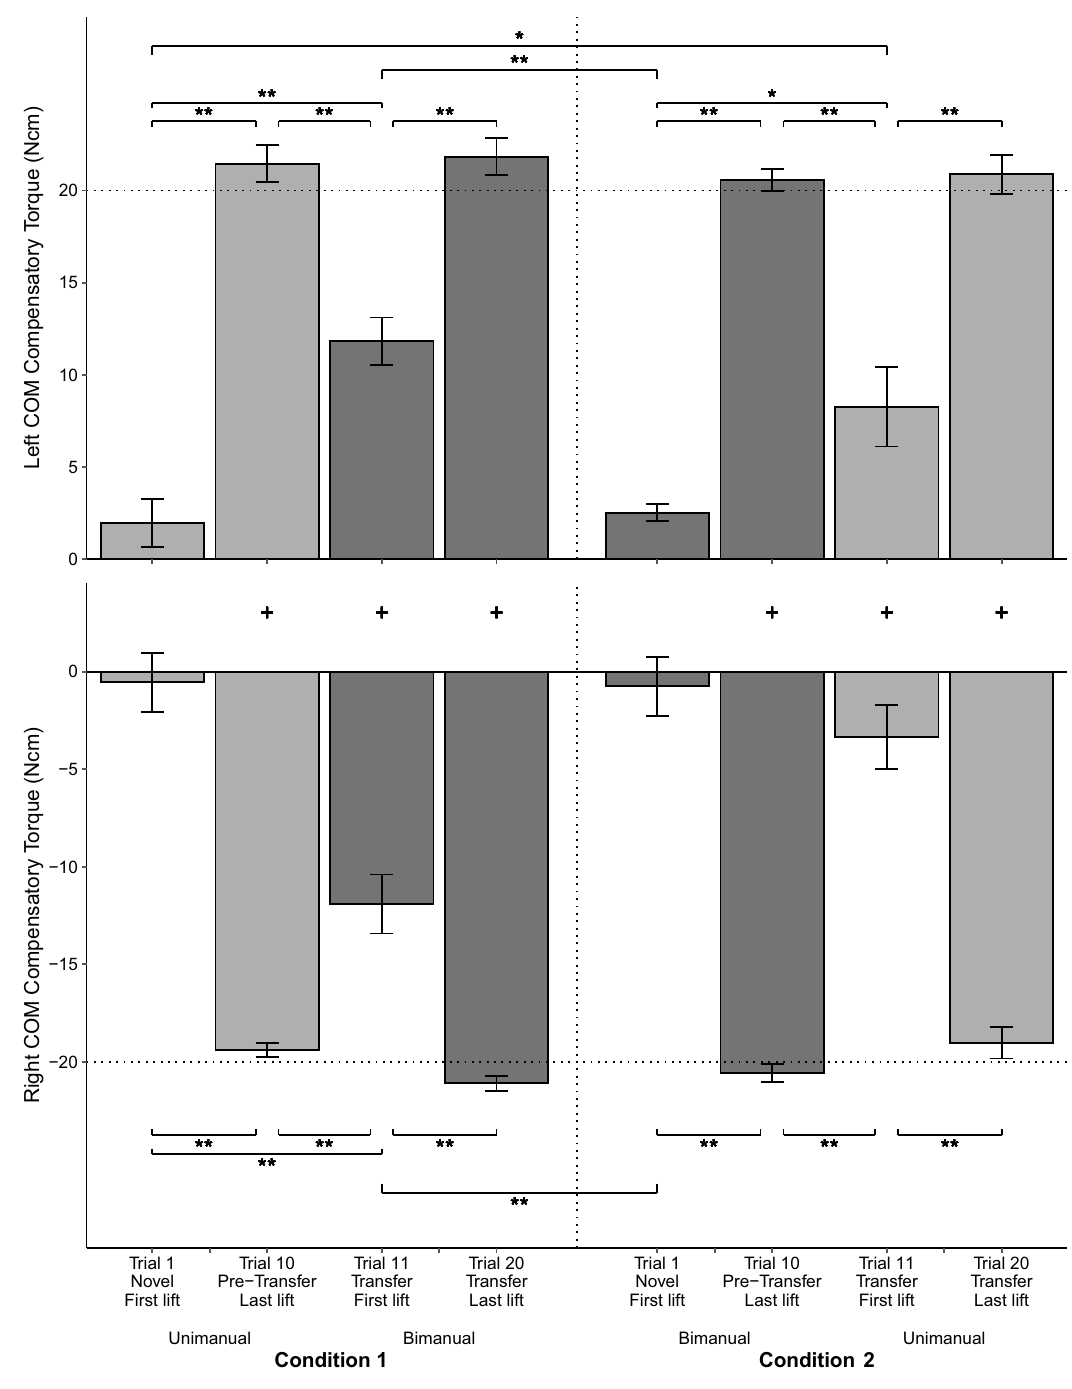
Figure 4. Results for Compensatory Torque (Tcom) across all conditions. Average Tcom for the left COM (top panel) and right COM (bottom panel) for the novel first trial, pre-transfer trial 10, transfer trial 11, and trial 20 (± s.e.m). Light grey bar indicates Tcom for the right-hand unimanual trials. Dark grey bar indicates Tcom for the bimanual trials. Error bars indicate the standard error of the mean. Horizontal lines indicate the target Tcom while the vertical line separates condition 1 (left panel) from condition 2 (right panel). * p < .05, ** p < .001, + p < .05 between the left and right